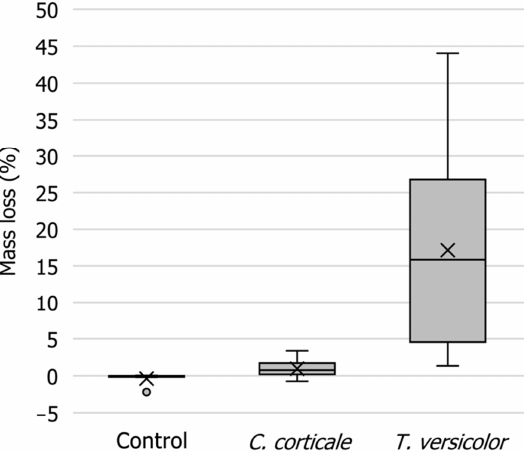
Figure 8. Boxplot showing mass loss (%) of Acer pseudoplatanus samples after 10 weeks of exposure to Cryptostroma corticale and Trametes versicolor . The boxplot represents the minimum, first quartile, median, third quartile, and maximum values; × designates average value; the dots show outlier